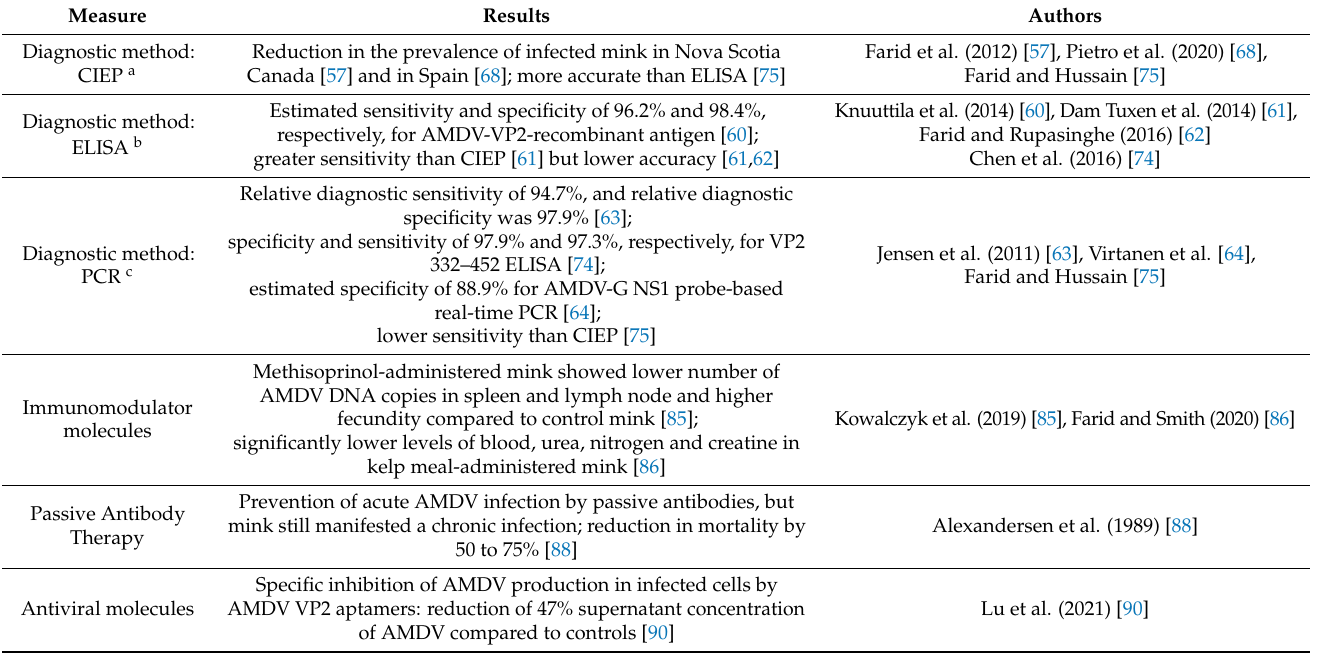
Table 1. Some of the AMDV Preventative Measures Proposed: Diagnostic and Reduction Methods. Measure